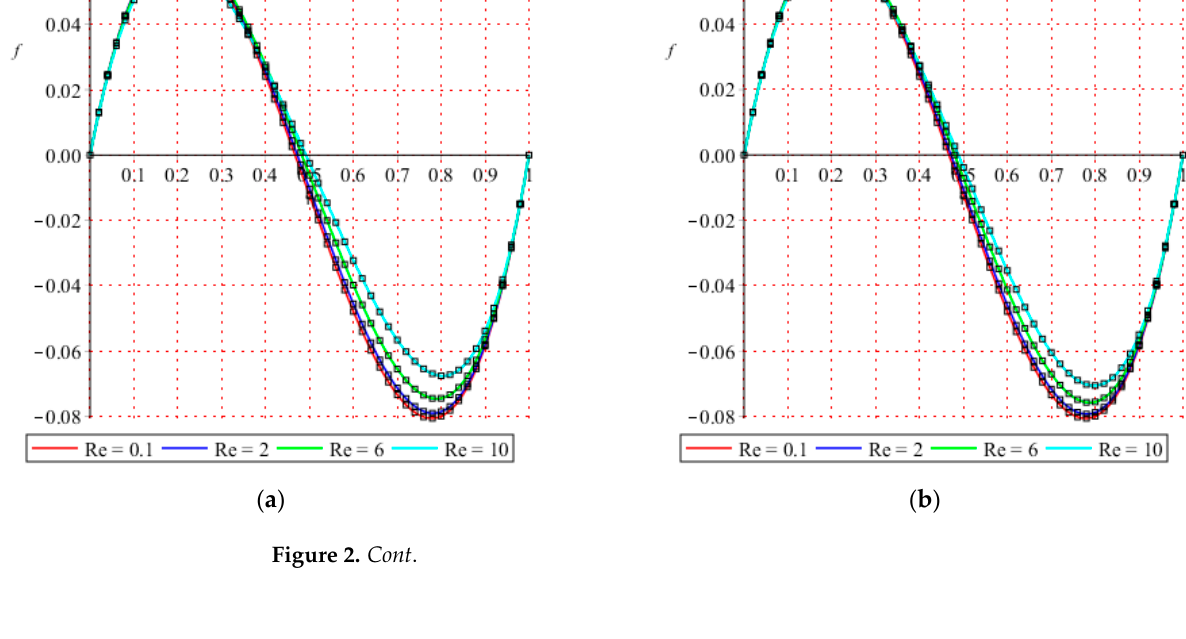
( d ) Figure 2. Influence of Re on velocities ( a , b ). Axial 𝑓(cid:4666)𝜂(cid:4667) . ( c , d ). Tangential 𝑔(cid:4666)𝜂(cid:4667) . ( a ) SWCNTs , ( b ) MWCNTs , ( c ) SWCNTs , ( d ) MWCNTs .